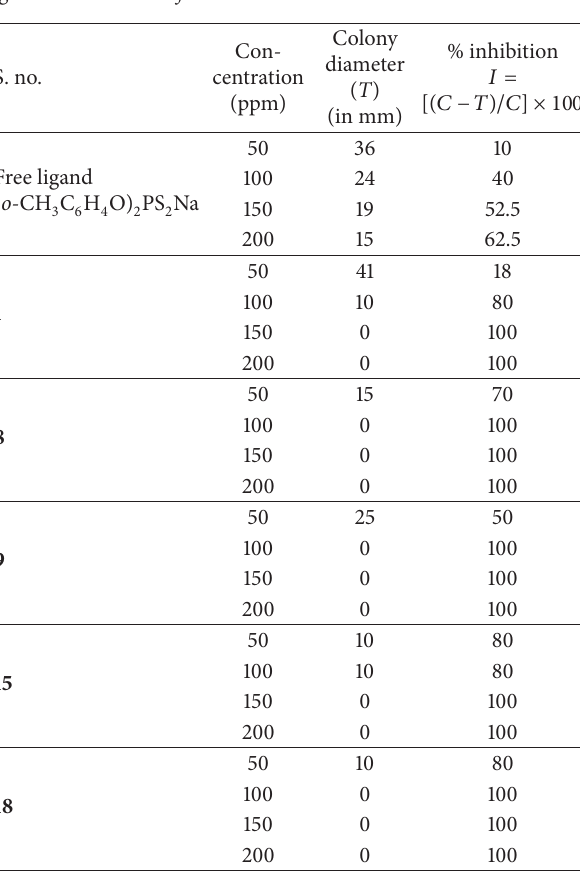
Table 7: In vitro evaluation of Mn(II) ditolyldithiophosphates against Sclerotium rolfsii .